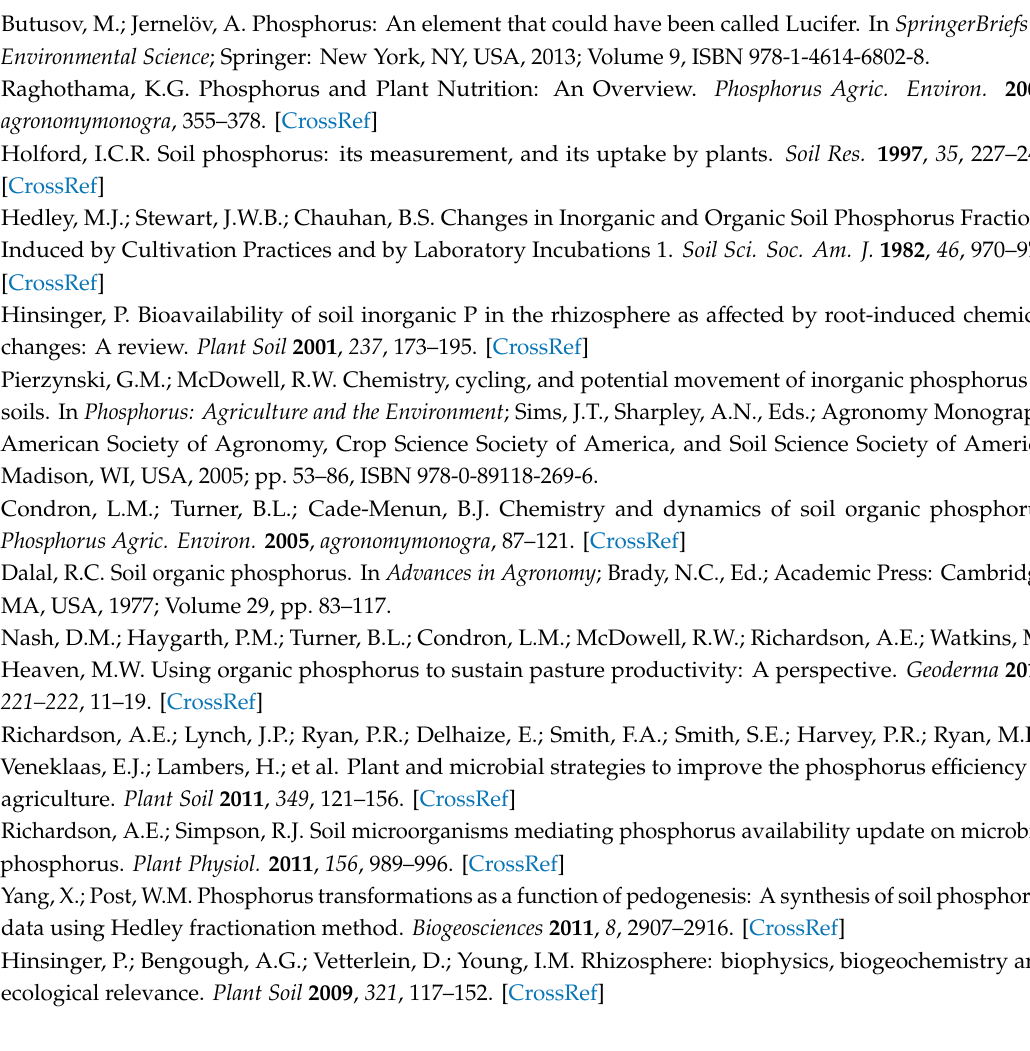
Table S1: Distribution of di ff erent soil P fractions for the four treatments at day 0. The control and N treatments are reported in the same column as the P and NP treatments. Figure S1: Concentrations of organic anions expressed by unit of root dry matter in the rhizosphere of blue lupin, wheat, ryegrass, and white clover for the control (0N, 0P), P (0N, 33P), N (200N, 0P), and NP (200N, 33P) treatments. Di ff erent letters represent a significant di ff erence ( p < 0.05) among nutrient treatments for the same plant. Di ff erent superscript letters represent a significant di ff erence ( p < 0.05) among plant species for the same nutrient